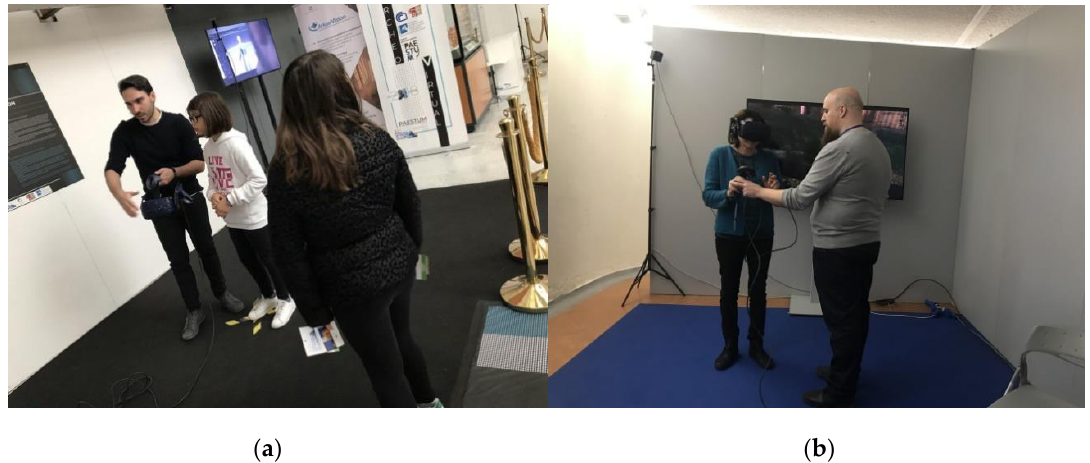
Figure 15. Pictures of two evaluative sessions: ( a ) during Archeovirtual exhibition, Paestum and ( b ) during TourismA, Florence. Copyright © CNR ISPC.